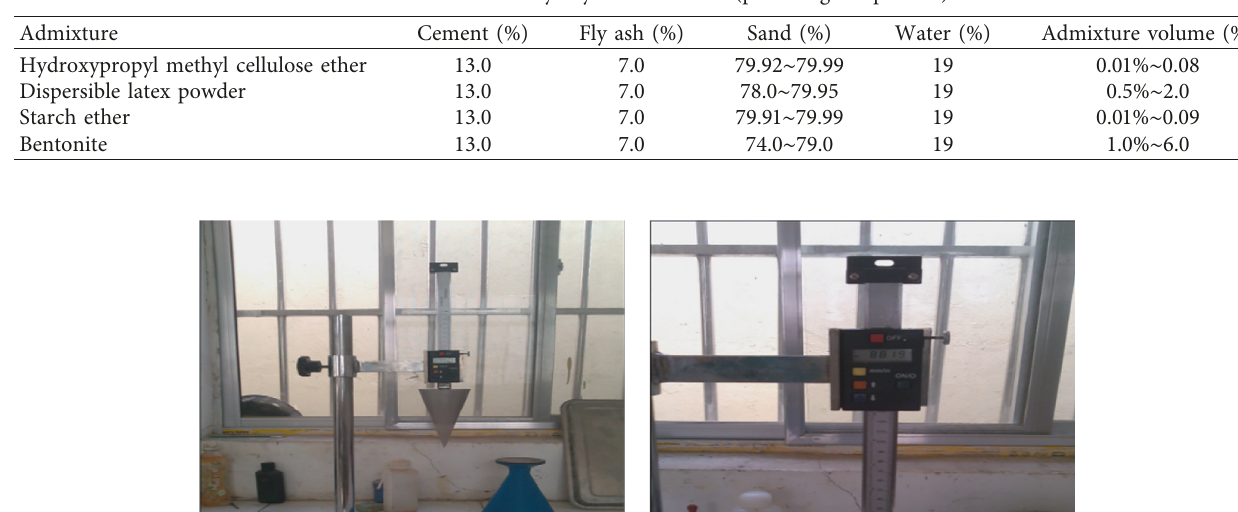
Table 4: Mix of ordinary dry-mixed mortar (percentage of powder).